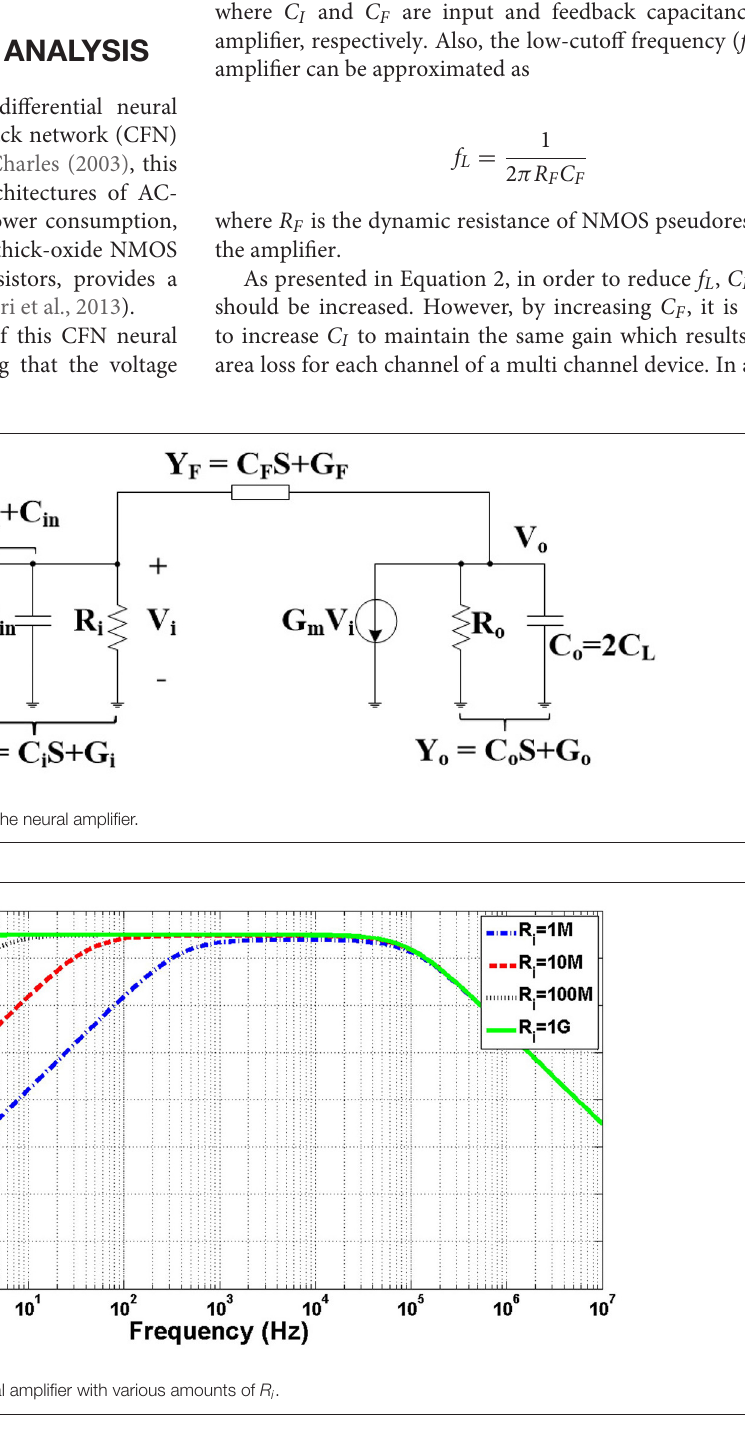
Frontiers in Neuroscience |